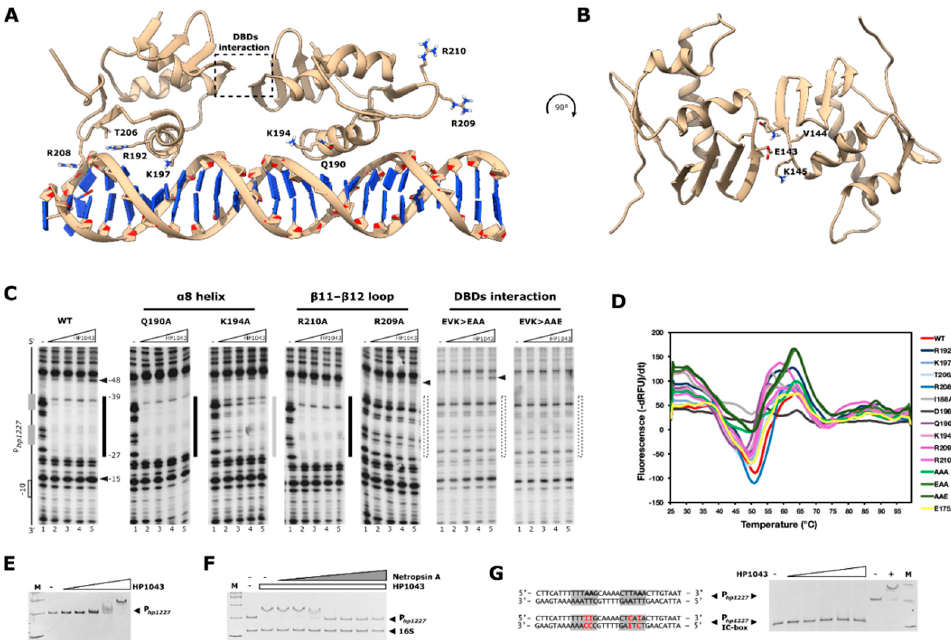
Figure 3. Validation of HP1043- P hp1227 interaction model. ( A ) HP1043_DBD- P hp1227 computational model depicted as ribbon. On the left, amino acid residues are used as restraints to guide the dock- ing, on the right, residues are tested to validate the model. The region of putative interaction be- tween HP1043 DBDs is highlighted. ( B ) View from above. Residues presumed to be involved in the HP1043 DBDs interaction are exposed. In ( A , B ), protein and DNA backbone are depicted as ribbon and colored in tan. Selected residues are depicted as stick and colored by heteroatom. ( C ) DNase I footprinting experiments were performed to validate the docking model, where residues K194 and R209, but not amino acids Q190 and R210, interact with DNA. On the right, in vitro binding exper- iment to investigate the putative interaction among HP1043 DBDs, by mutation of residues 143–145. Experiments were executed as described in the legend to Figure 2. WT, wild-type HP1043 protein; Q190A, K194A, R201A, R290A, EVK > EAA, EVK > AAE, amino acid substitutions in the HP1043 protein. ( D ) Representative first derivative curves of fluorescence obtained in a thermal stability shift assay performed on wild -t ype and mutant HP1043 proteins in the presence of SYPRO orange. The minimum of the curves corresponds to the protein melting temperature. ( E – G ) Electrophoretic mobility shift assays (EMSAs) to validate HP1043 interaction with minor and major grooves of the DNA. In ( E ), EMSA to estimate the concentration of HP1043 required to shift the target probe. Eighty pmol of a 100 bp probe encompassing the HP1043 binding site on the hp1227 promoter were incu- bated with increasing concentrations of purified recombinant HP1043 (0, 1, 2, 4, 8, 16 µM). In ( F ), EMSA in the presence of a fixed amount of HP1043 (8 µM) and increasing concentrations of the DNA minor groove binder Netropsin (0.001, 0.01, 0.1, 1, 10, 100, 500 µM, indicated as a grey trian- gle). A 60 bp probe of the 16S rRNA gene was used as an internal specificity control. In ( G ), increas- ing amounts of HP1043 (0, 8, 12, 16, 20, 24 µM) were incubated with a P hp1227 probe harboring IC-box substitutions in the sequences recognized by HP1043. To control the reaction, 8 µM HP1043 was incubated with the wild - type P hp1227 DNA. IC - box substitutions are highlighted in red, hexamers of the HP1043 consensus binding sequence are enclosed in grey boxes. In ( E – G ), HP1043 concentration is indicated as a white triangle when used in increasing amount (in E and G), or as a white rectangle when used at a fixed concentration (in F). The DNA molecular weight ladder is indicated as M, the addition or lack of a component in the reaction mixture is indicated with a plus “+” or minus “-” sign, respectively.